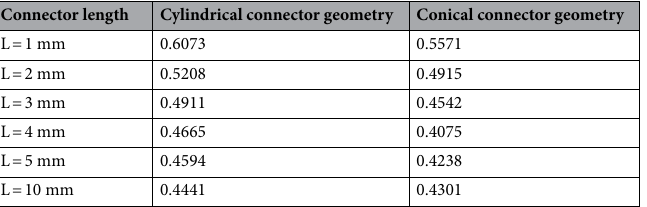
Table 1. Mean Hoover coefficient of fluid flow in scaffolds with cylindrical and conical connector geometries with varying connector lengths.